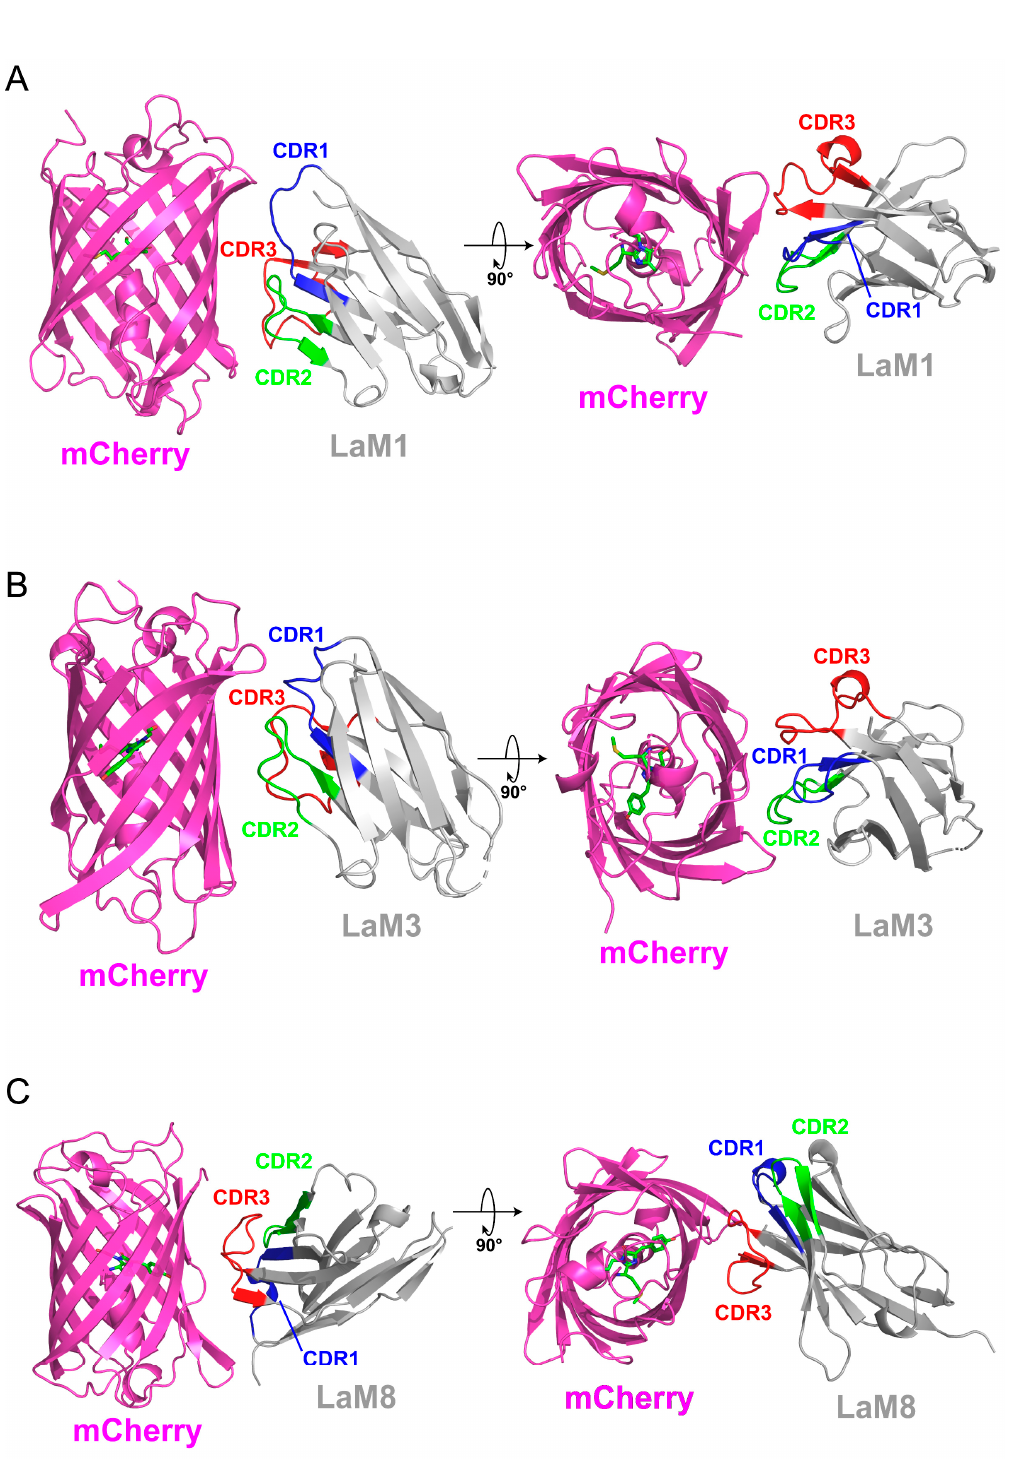
Figure 1. Overall crystal structures of mCherry-LaM complexes. CDR1, CDR2, and CDR3 are shown in blue, green, and red, respectively, and non-hypervariable regions are gray, mCherry is magenta, and the chromophore is a stick-like structure in green. ( A ) A schematic representation of the mCherry-LaM1 heterodimer. ( B ) A schematic representation of the mCherry-LaM3 heterodimer. ( C ) A schematic representation of the mCherry-LaM8 heterodimer.